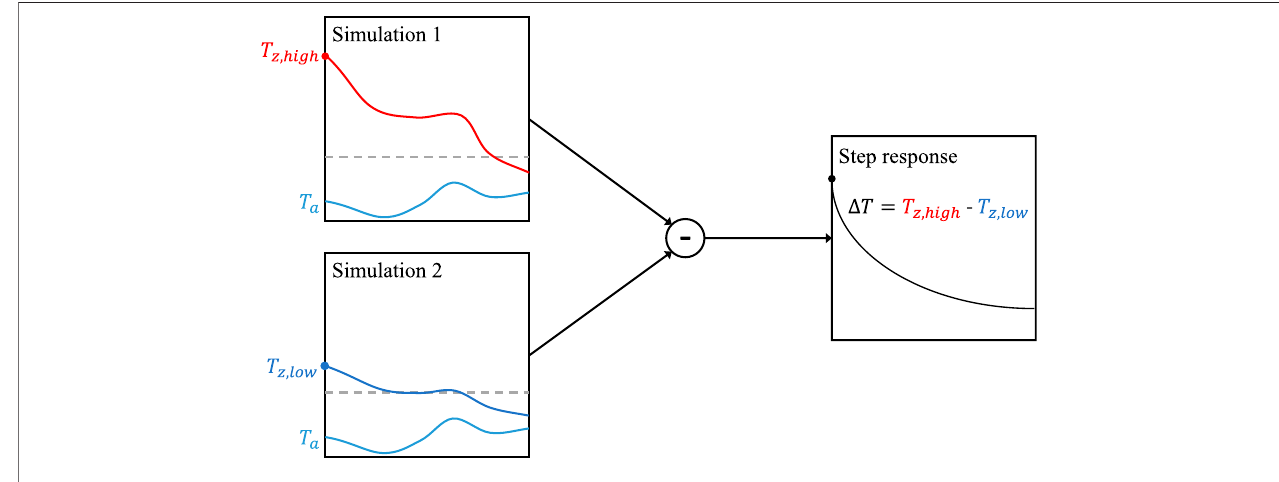
FIGURE 5 | Schematic representation of the process used to estimate the building step response in BOPTEST.